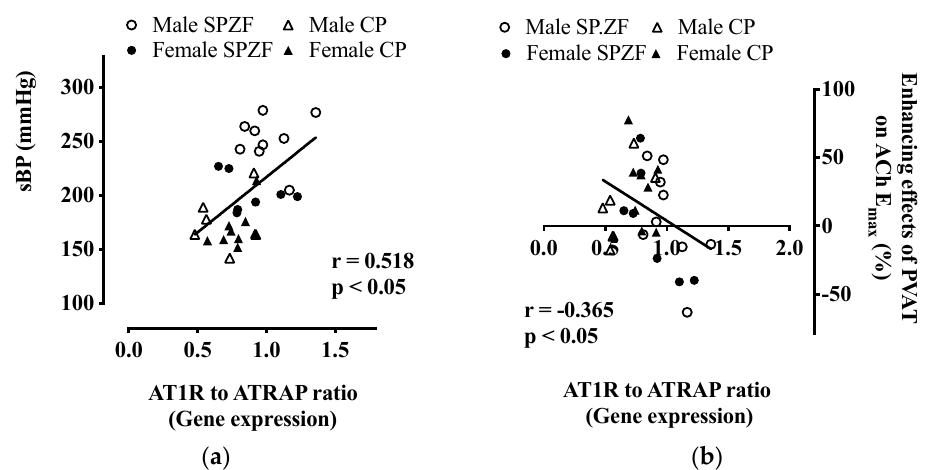
Figure 5. Correlations between systolic blood pressure and mRNA expression of angiotensin II type 1 receptor (AT1R) to AT1R-associated protein (ATRAP) ratio ( a ), and the AT1R to ATRAP ratio and enhancement of acetylcholine-induced relaxation by perivascular adipose tissues (PVAT) ( b ) in male and female SHRSP.Z- Lepr fa /IzmDmcr rats (SHRSP.ZF) and SHR/NDmcr-cp rats (CP) at 23 weeks of age. Relaxation enhancement was assessed by differences in maximum response to acetylcholine with or without PVAT. Data are expressed as means ± SEM. n = 9 rats/group.